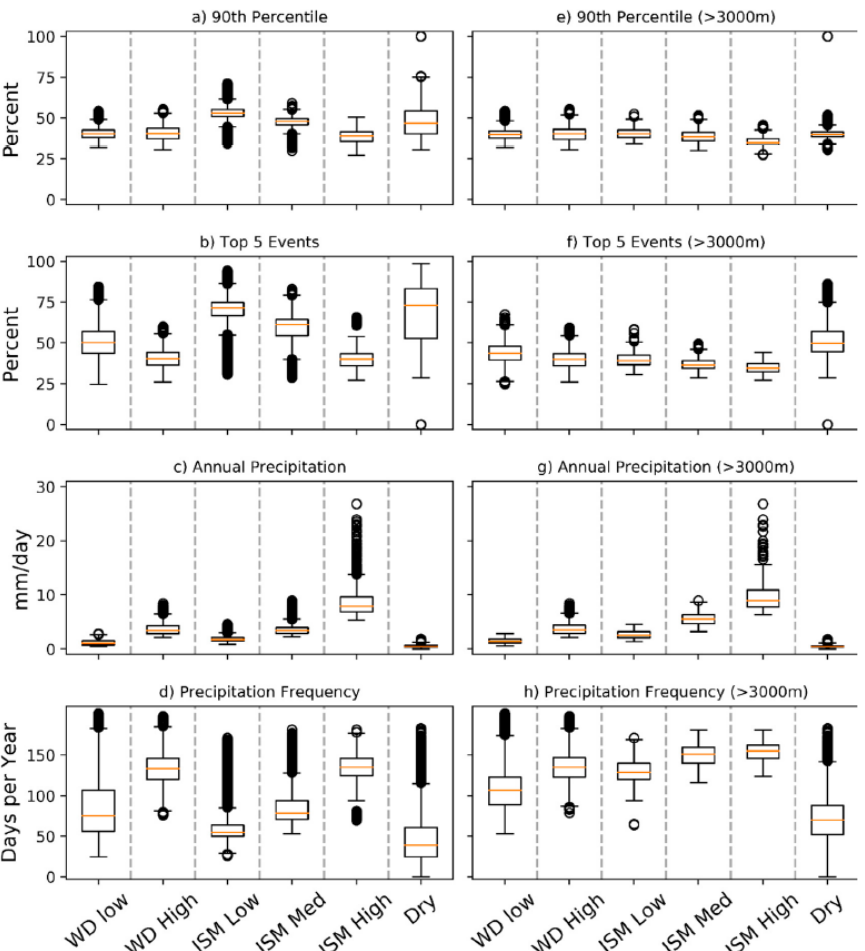
Figure 5. Box-and-whisker plots displaying 90th percentile contribution, top 5 event contribution, annual precipitation, and precipitation frequency for each cluster in the K-means clustering (left pan- els) and for elevations >3000 m for each cluster (right panels). Orange line indicates median, box the interquartile range, the lower whisker at Q1—1.5*IQR, upper whisker at Q3 + 1.5*IQR (where Q1 is the 25th percentile value, Q3 is the 75th percentile value, and IQR is the interquartile range), and circles outliers. ( a ) 90th percentile; ( b ) top 5 events; ( c ) annual precipitation; ( d ) precipitation frequency; ( e ) 90th percentile (>3000 m); ( f ) top 5 events (>3000 m); ( g ) annual precipitation (>3000 m); ( h ) precipitation frequency (>3000